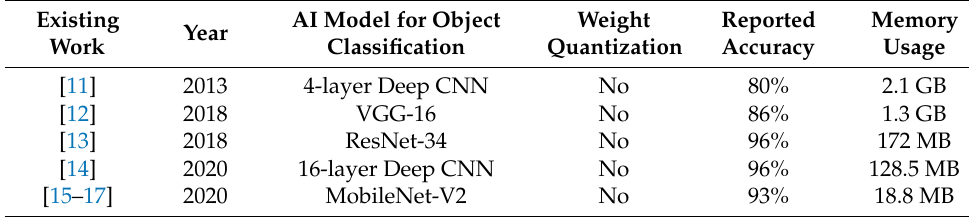
Table 1. Summary of existing deep AI models for classification of indoor litters by robot vacuums.